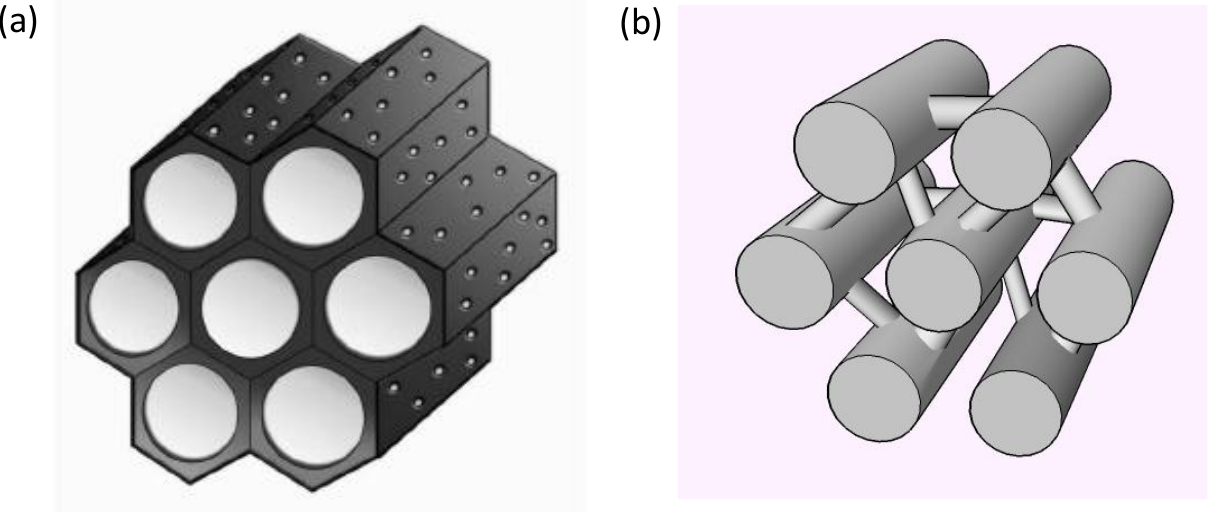
Figure 6. ( a ) Schematic representation of 2D hexagonal mesoporous structure of SMC and ( b ) the interconnected nanorod structure of